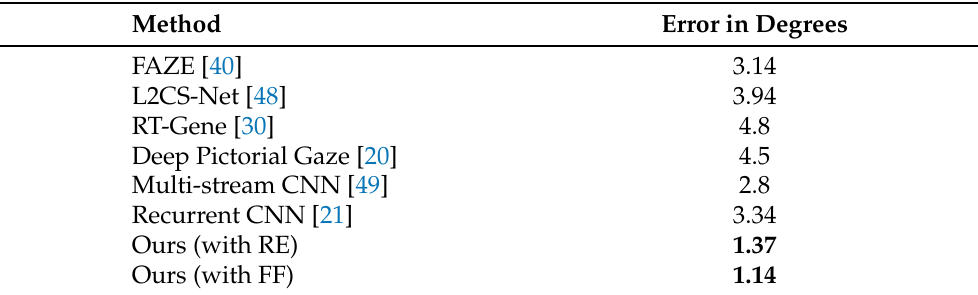
Table 9. Angular errors of our method in comparison with other state-of-the-art